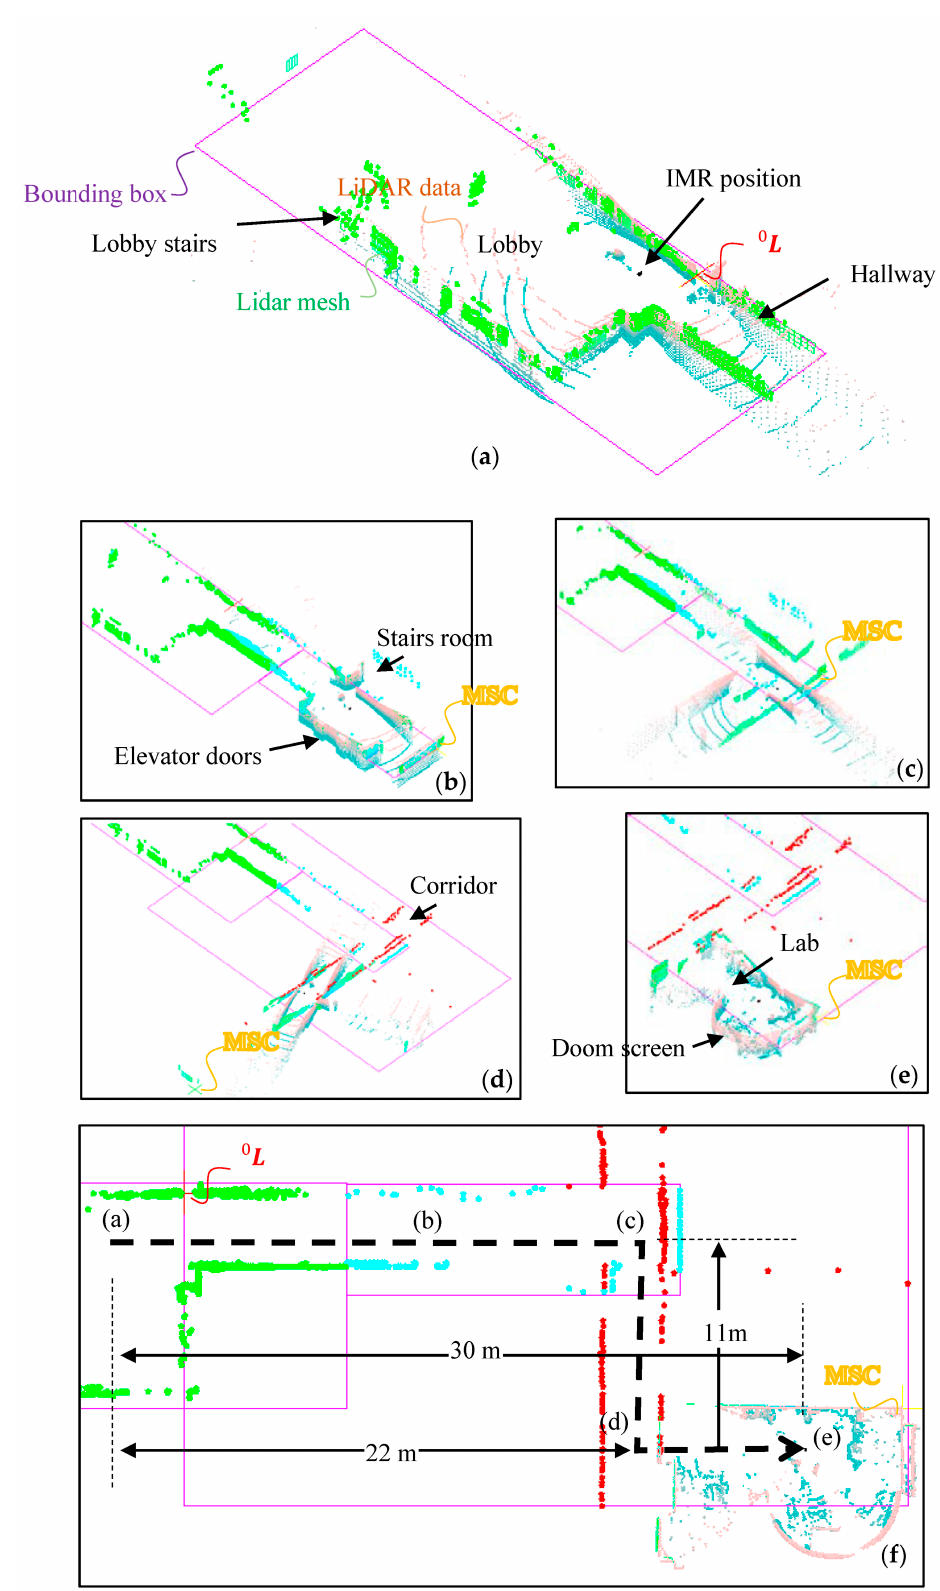
Figure 13. IMR navigation from ( a ) the lobby and proceeds to ( b ) Hallway, ( c ) Corner, ( d ) Corridor, ( e ) the lab on, ( f ) e-SLAM